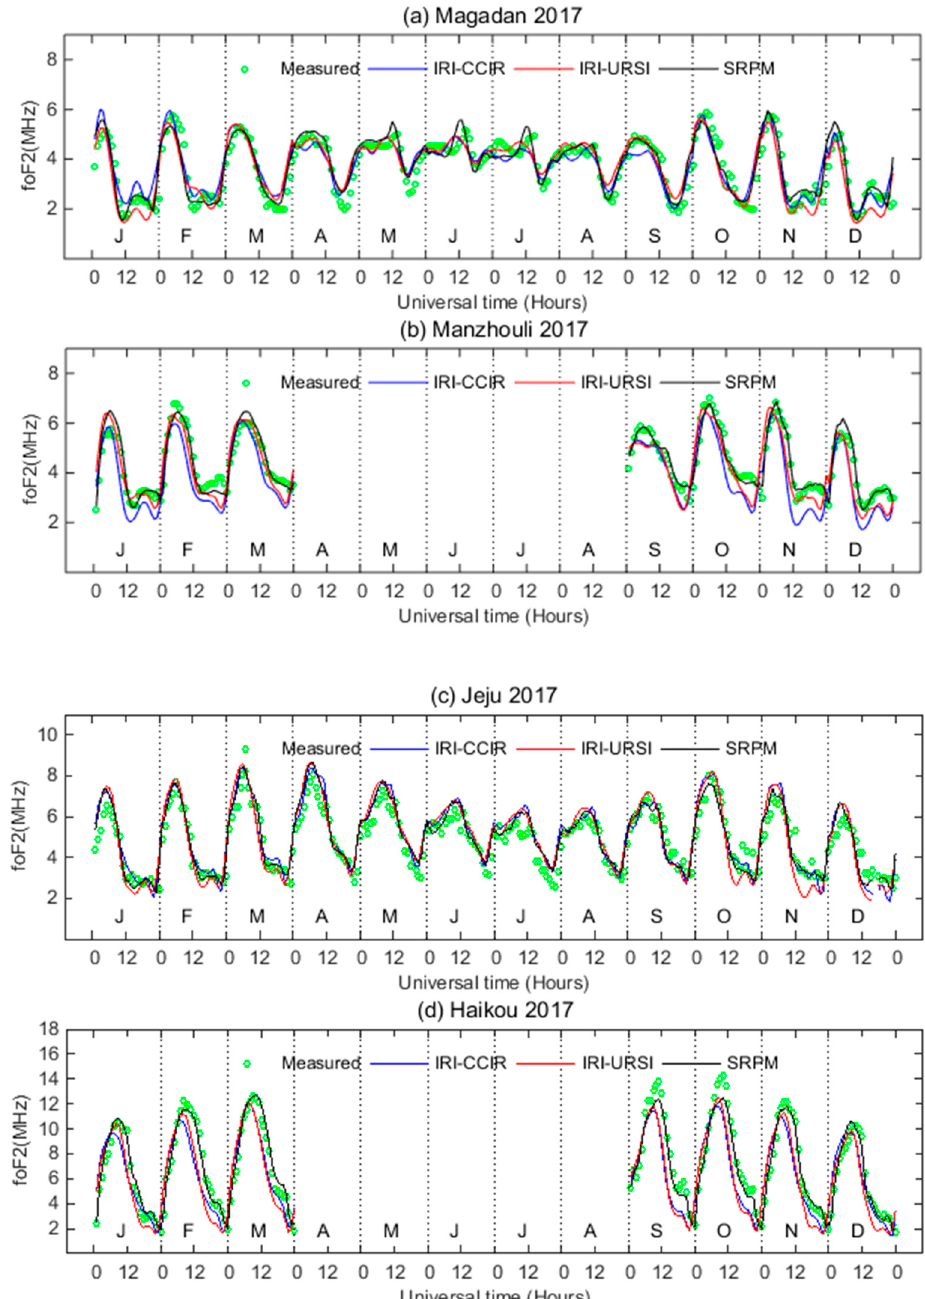
Figure 11. Sample plots of different model predicted value and measured value of f o F 2 for the year 2017 (low solar activity year). From top to bottom panels, stations are ordered from high, middle and low latitude, which are Magadan, Manzhouli, Jeju and Haikou stations. ( a ) Magadan station; ( b ) Manzhouli station; ( c ) Jeju station; ( d ) Haikou station.